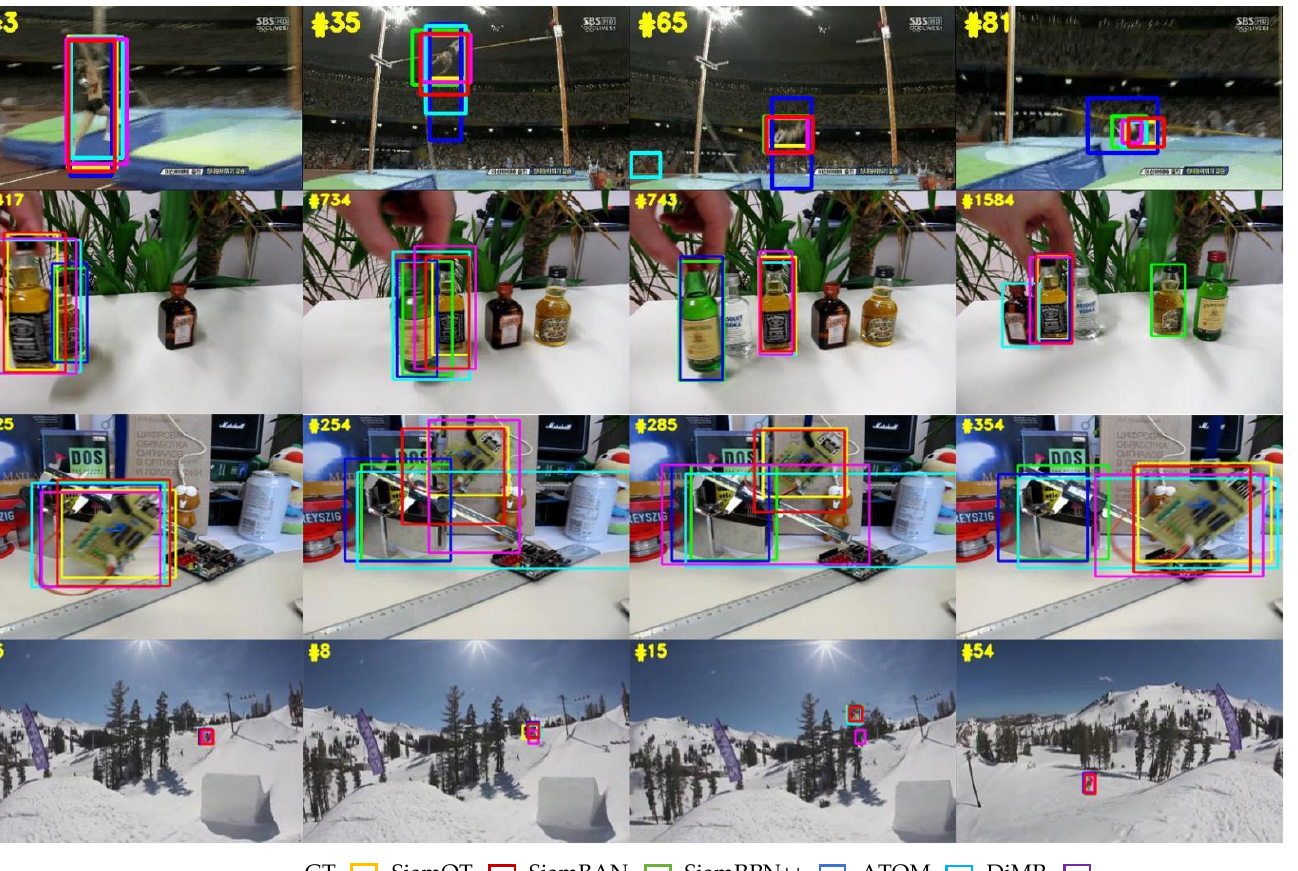
Figure 7. Qualitative comparison of our tracker with other popular trackers on 4 video sequences from OTB100.